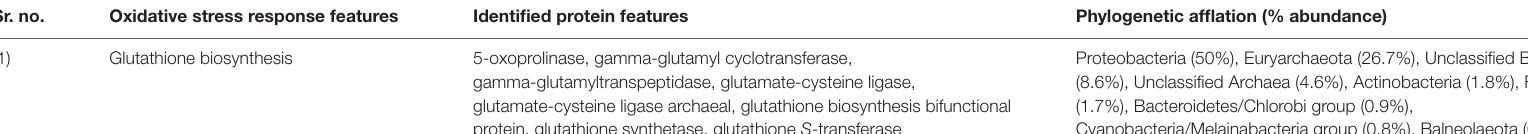
TABLE 2 | Metagenomic features associated with oxidative stress response physiology in Sambhar Salt Lake microbiome. Sr.